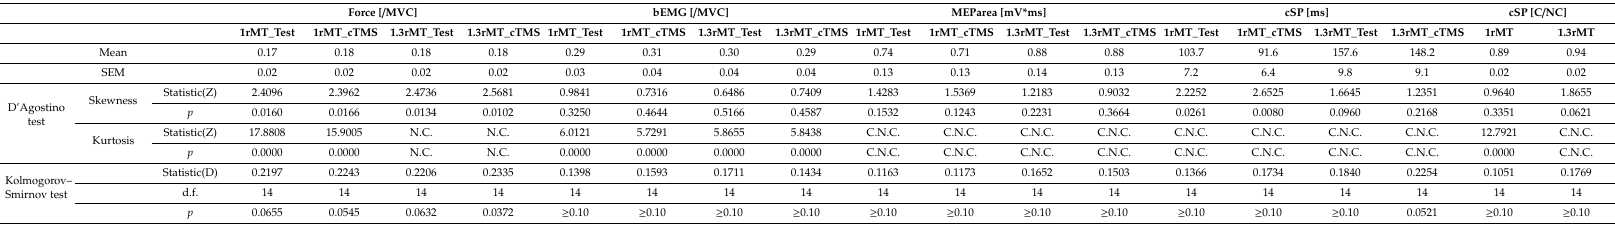
Table 1. Mean value and D’Agostino and Kolmogorov–Smirnov tests in the first experiment.